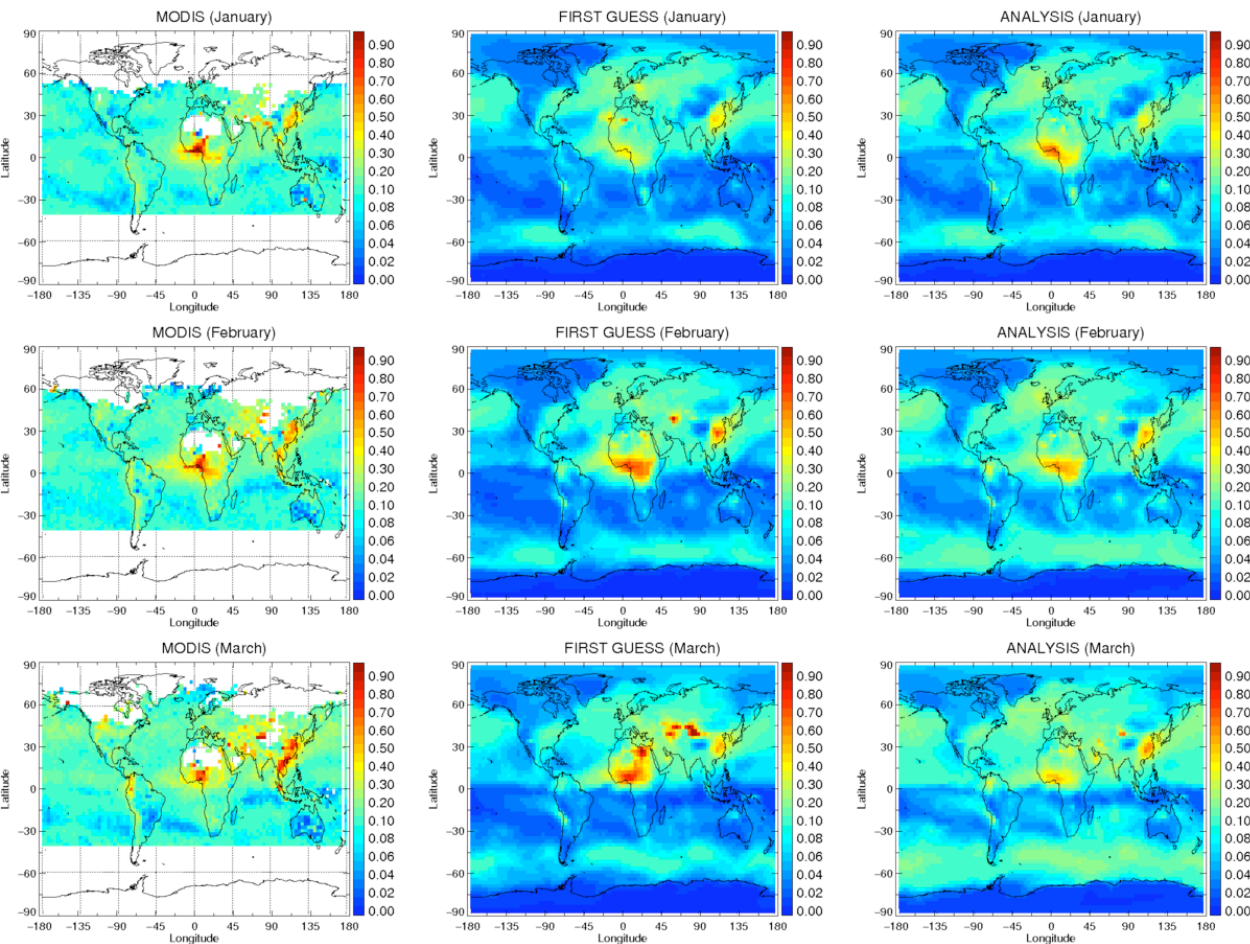
Figure 5. Fig. 5. Total AOD from MODIS (left), first guess (centre) and analysis (right) for the months of January (upper row), February (middle row) and March (lower row) of 2002. White colour corresponds to regions without data. Red colours indicate relatively high values while blue colours indicate relatively low